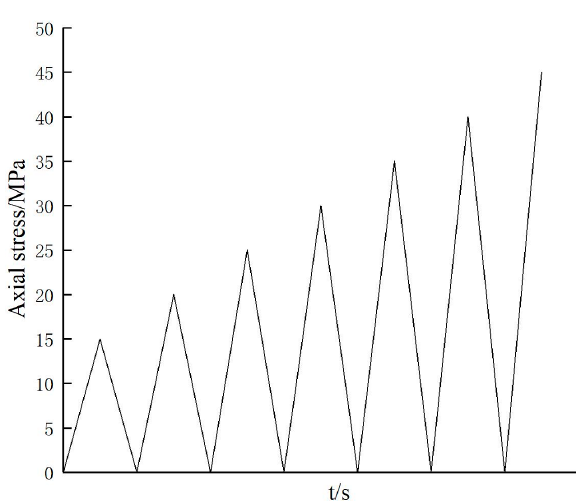
Figure 3. Schematic diagram of loading path.